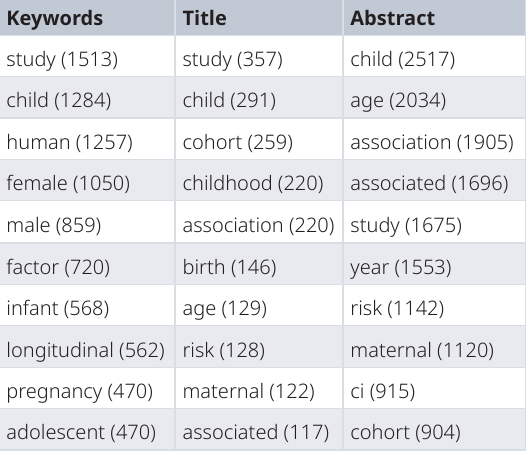
Keywords, titles and abstracts Table 5 shows the result of a frequency analysis of lemmatized keywords, title text and abstract text of all of the publications that have relevant metadata. These most frequent words correspond with the overall nature of ALSPAC – i.e. a birth cohort study which has followed its participants over a long period of time.